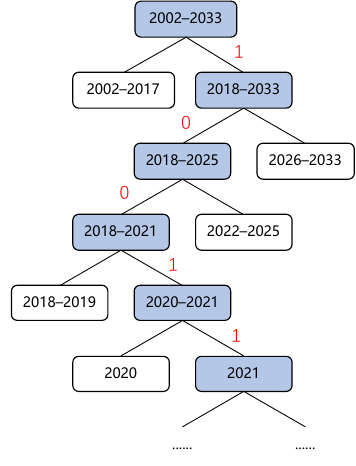
Figure 3. The diagram of time